Question: What does this figure show? Answer in one sentence.
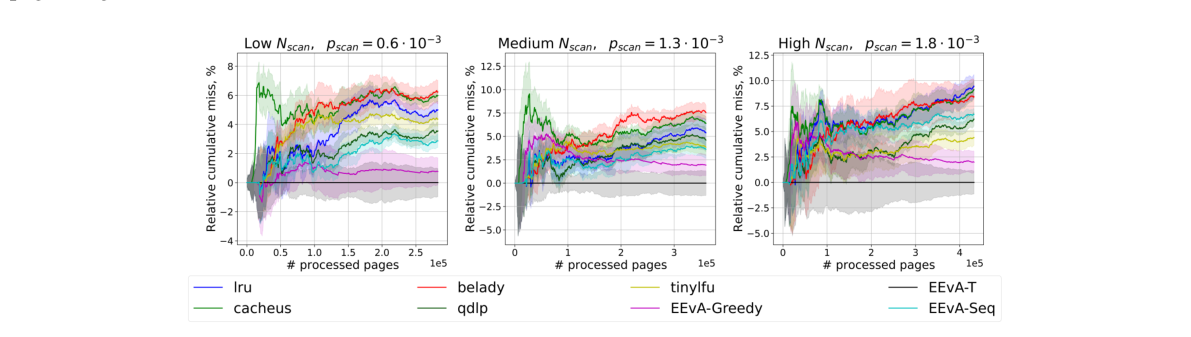
Answer: Comparison of the dynamics of the relative cumulative miss rate for the considered algorithms. EEvA-T gives the smallest values, therefore we consider it as the baseline. The reported averaged values and the corresponding half of variance are computed over 5 runs. Non-EEvA-based algorithms show significantly larger cumulative miss rates than our methods in all regular scenarios.